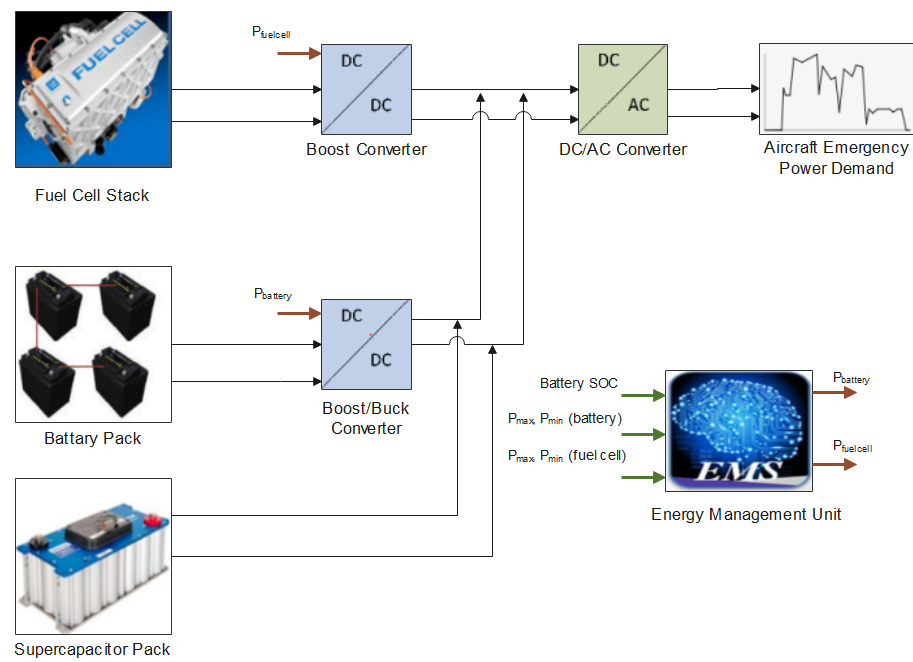
Figure 1. Topology of the energy storage system.